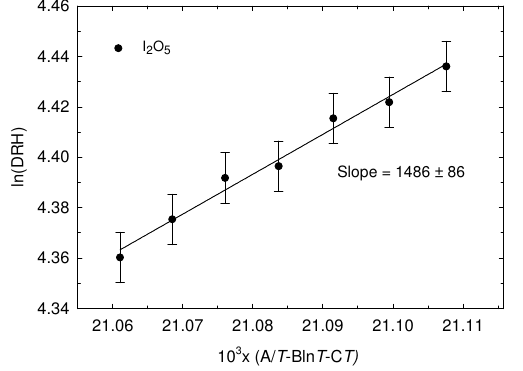
Fig. 8. A plot of measured deliquescence RH values for I 2 O 5 against the temperature function which includes calculated solubil- ity data (see Sect. 3.4).